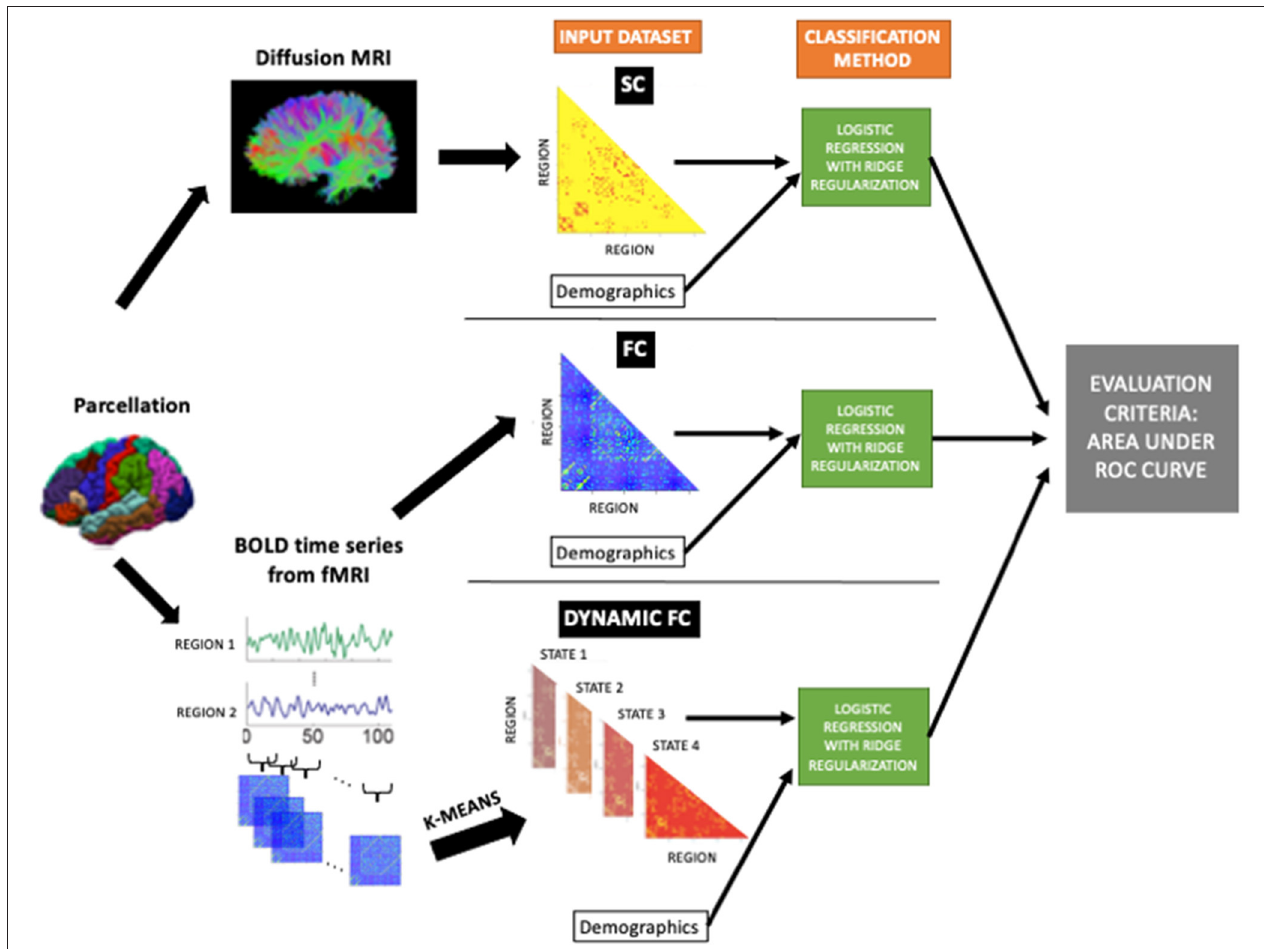
FIGURE 1 | The workflow of the study. Structural connectomes (SC), static functional connectomes (FC), and dynamic functional connectome (dFC) metrics were used as input, in addition to the demographics/clinical variables, to the classification model (logistic regression with ridge regularization technique). The classification performance of each model was assessed using the area under the ROC curve (AUC).